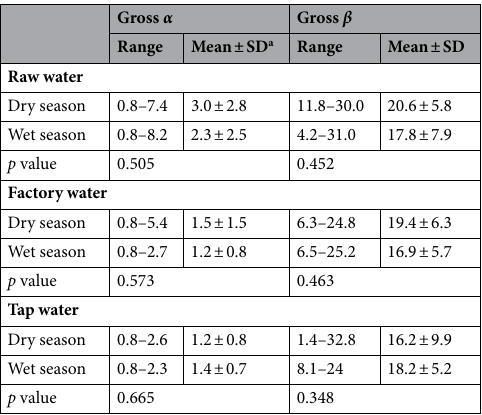
Table 4. The difference of the gross α and β radioactivity concentrations of drinking water samples in different periods (× 10 –2 Bq/L). a SD standard deviation of the activity concentration.